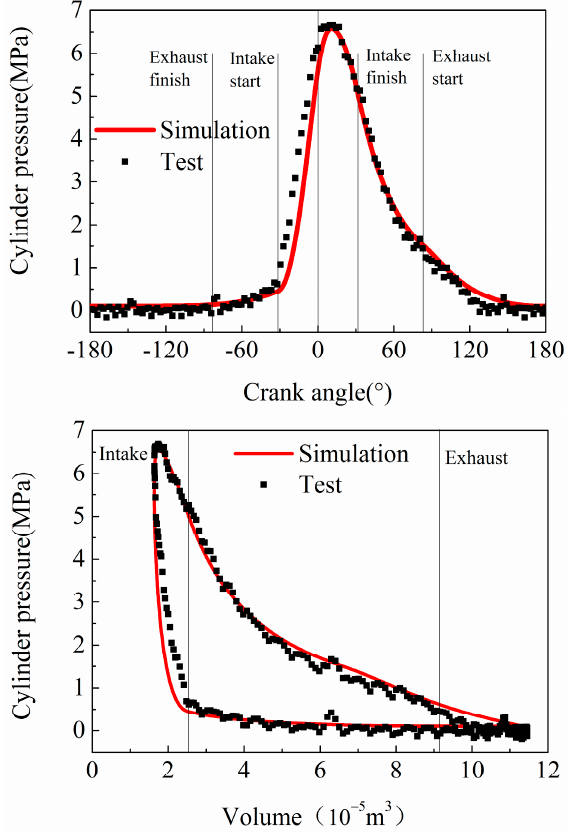
Figure 5. Indicator diagram of the expander for Case 4.